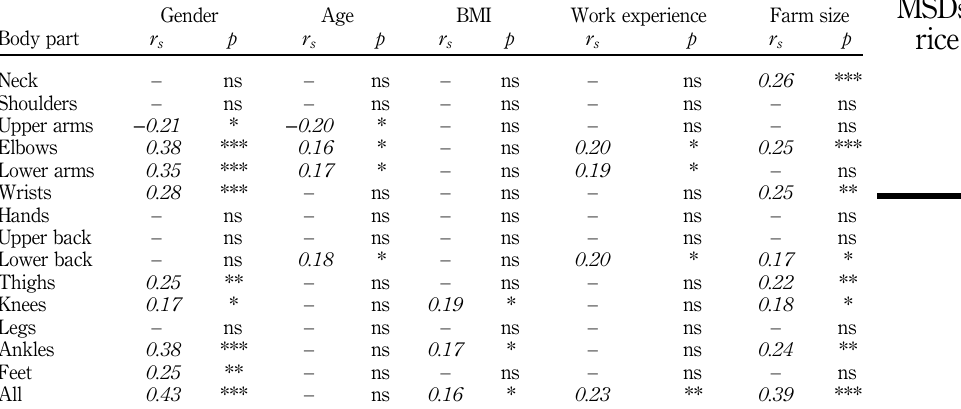
Table IV. Correlation between factors and pain levels by body